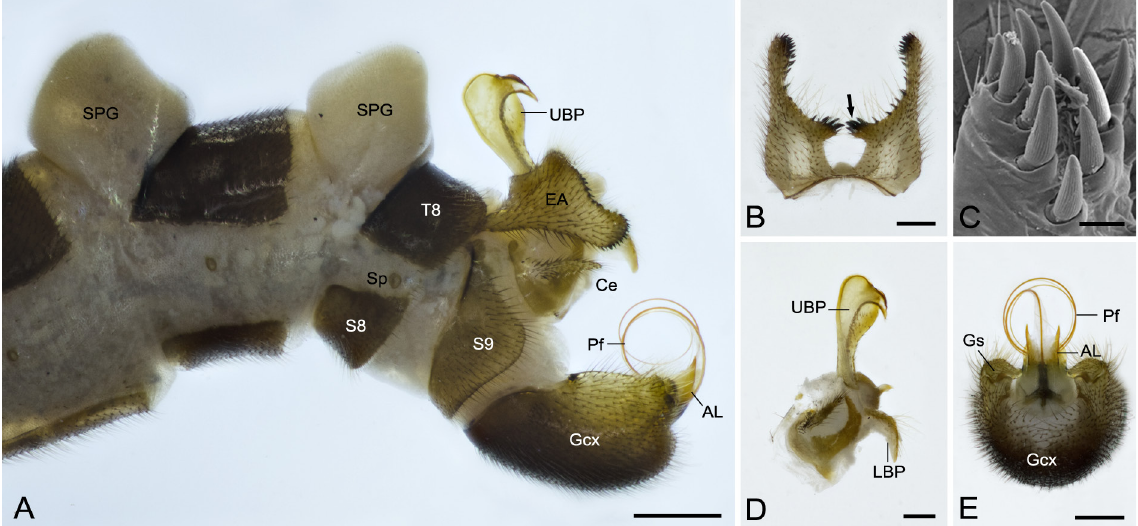
Fig. 3. Male genitalia of Terrobittacus rostratus sp. nov. A . Terminalia in lateral view. B . Epandrial appendages in dorsal view = arrow shows the dorsal process. C . Spines on dorsal process of epandrial appendages = SEM micrograph. D . Abdominal segment X and proctiger in lateral view. E . Genitalia in caudal view. Abbreviations: AL = aedeagal lobe; Ce = cercus; EA = epandrial appendage; Gcx = gonocoxite; Gs = gonostylus; LBP = lower branch of proctiger; Pf = penisfilum; S = sternum; Sp = spiracle; SPG = sex pheromone gland; T = tergum; UBP = upper branch of proctiger. Scale bars: A = 0.5 mm; B, D–E = 0.2 mm; C = 25 μm.